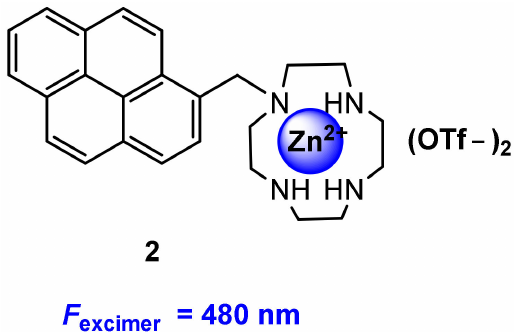
Figure 4. Chemical structure of probe 2